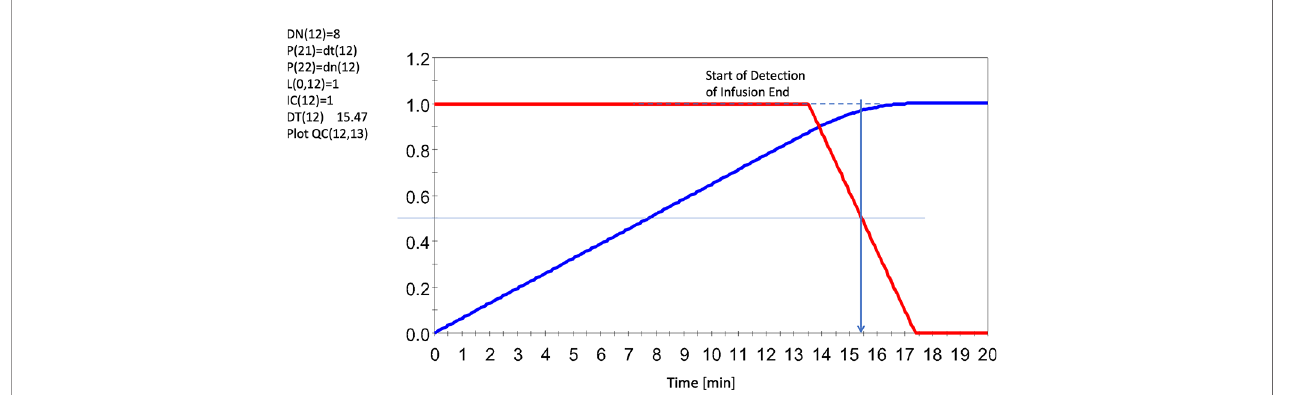
FIGURE 5 | Sensing the End of the Infusion Using an 8 Cell Delay System (red line), and accumulated input lactate infusion UF (13) = 1.F (12)/DT (12) (blue line). Note dashed line regarding agreements of results. Note this infusion seemed to run for slightly over 15 mins (albeit slowly here) whereas the average for all infusions was ~14 min. Red line represents the solution to F (12). Horse 5 shown here. All levels were scaled to invoke generalizability. For further details, see Supplementary Data 2 and Supplementary Data 3